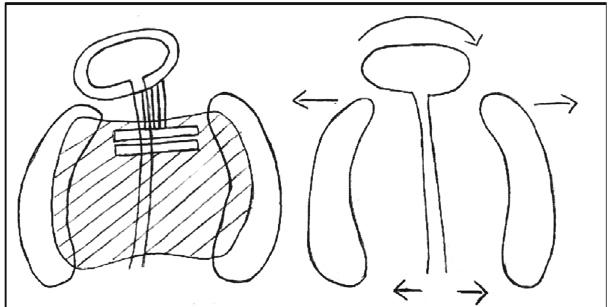
Figure 4: O ff -centred screw position to correct the rotation of